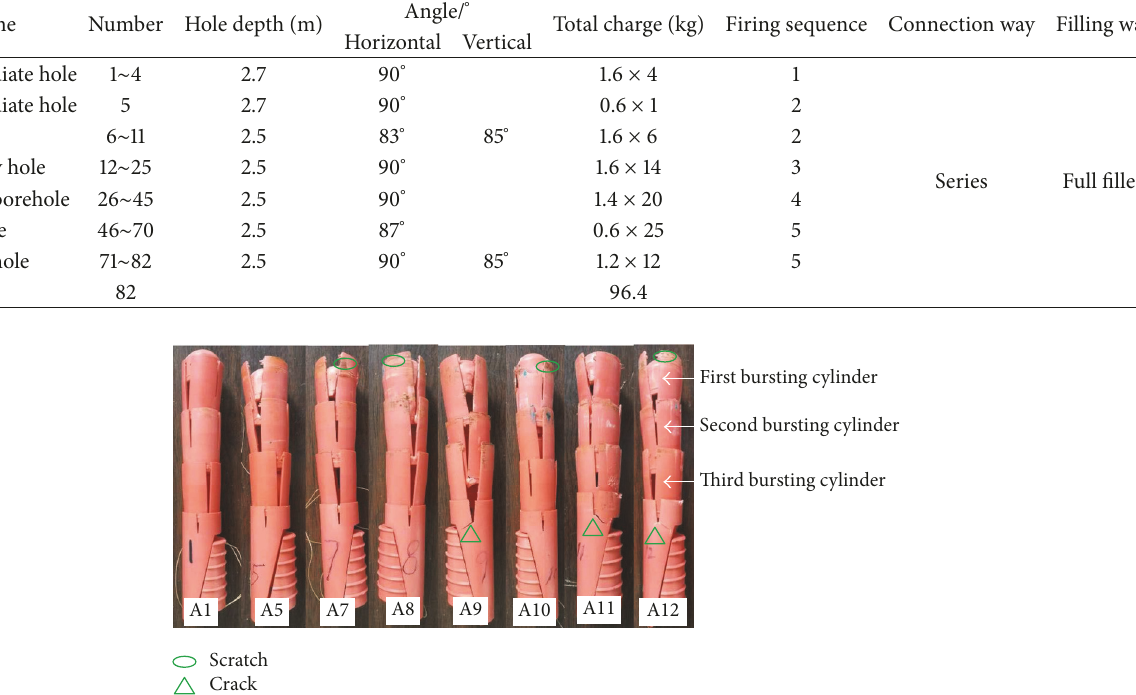
Table 6: Drilling pattern and charge weight in return entry.